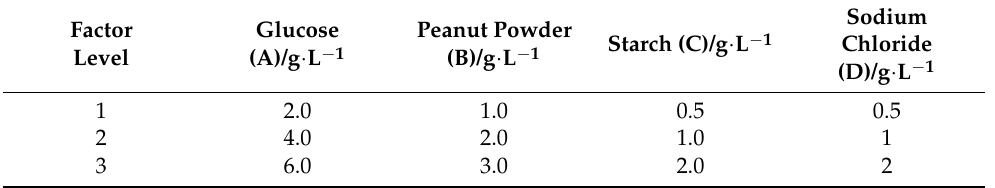
Table 5. L9(3 4 ) orthogonal design.